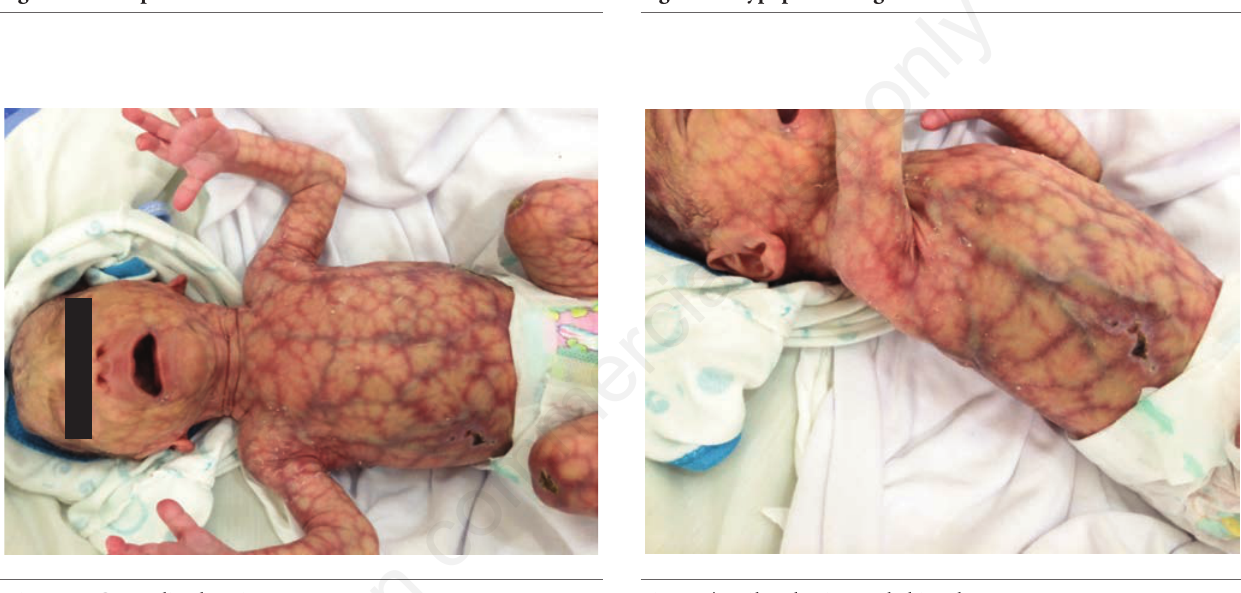
Figure 3. Generalized cutis marmorata. Figure 4. Dilated veins and skin